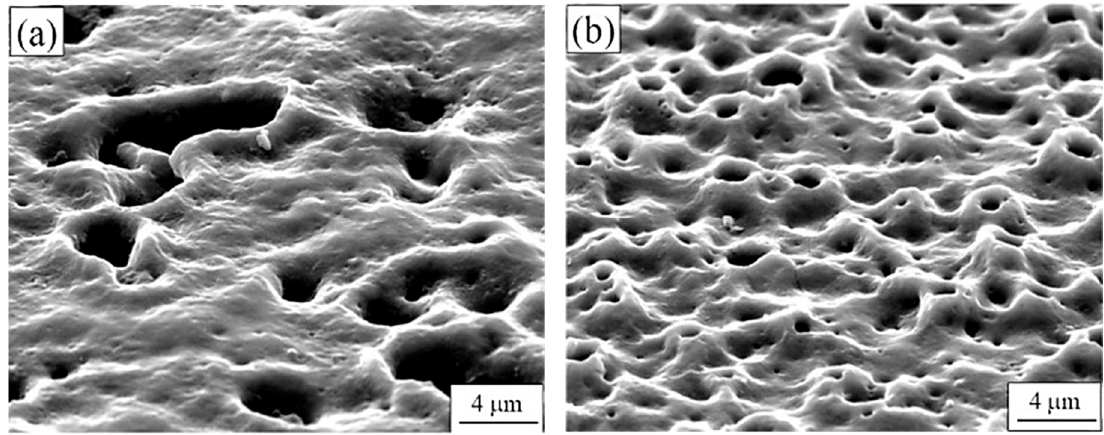
Figure 11. SEM images obtained after PEO process on a titanium sample in the presence of ( a ) K 3 PO 4 electrolyte and ( b ) K 4 P 2 O 7 electrolyte. Reproduced with permission from [108]. Copyright Elsevier, 2011.